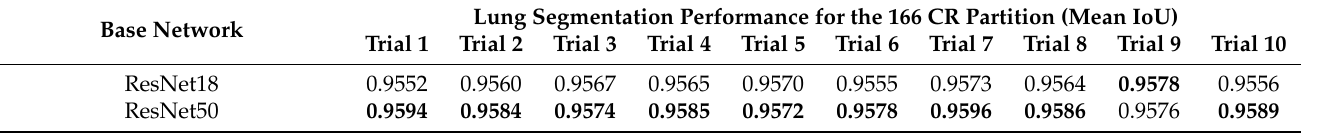
Table 4. Mean IoU values of the lung segmentations obtained for the 166 CR partition using DeepLabv3+. The highest IoU for each trial is marked in